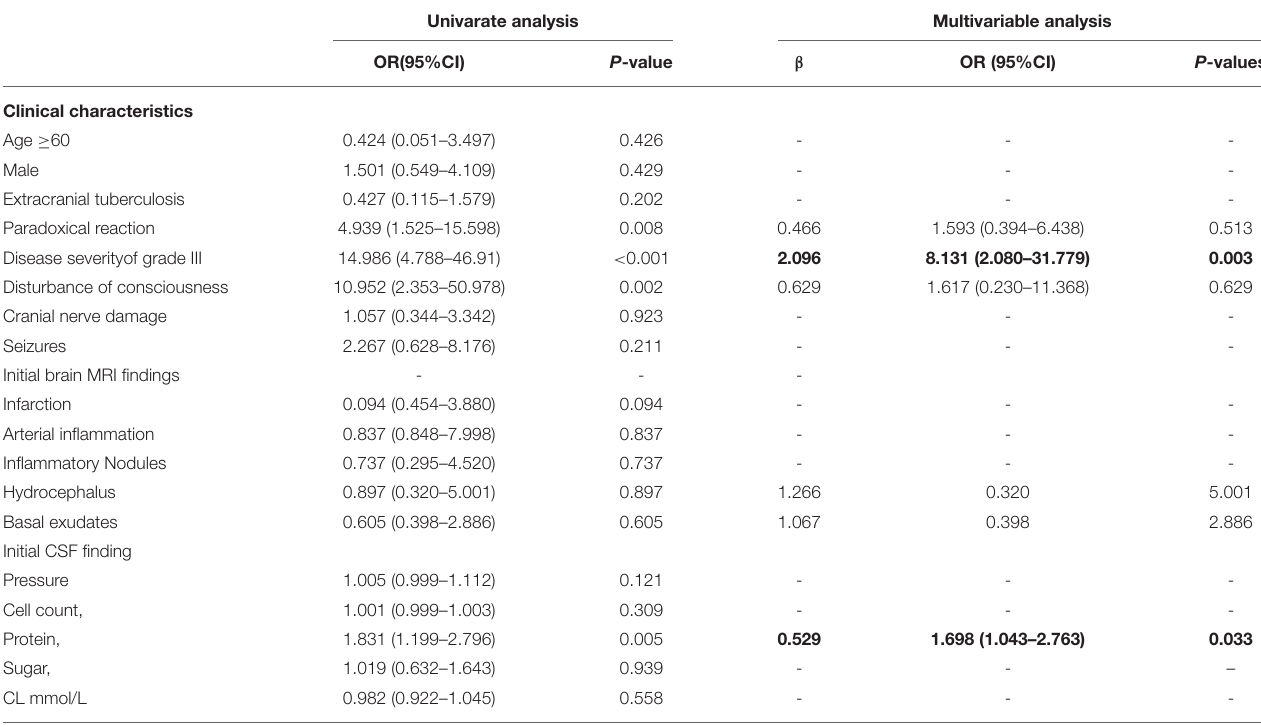
TABLE 2 | The univariate and multivariate logistic regression analysis for the risk factors of myelitis in patients with TBM.